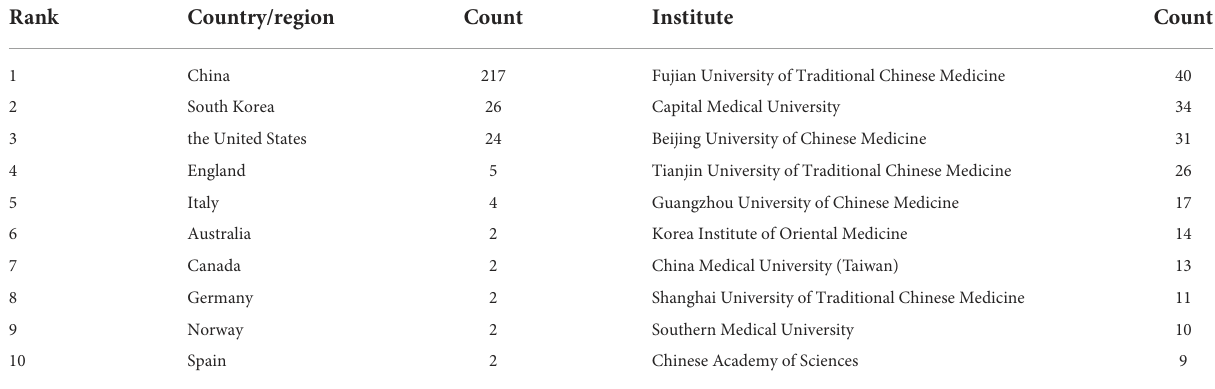
TABLE 3 Top 10 countries/region and institutions in the number of publications.